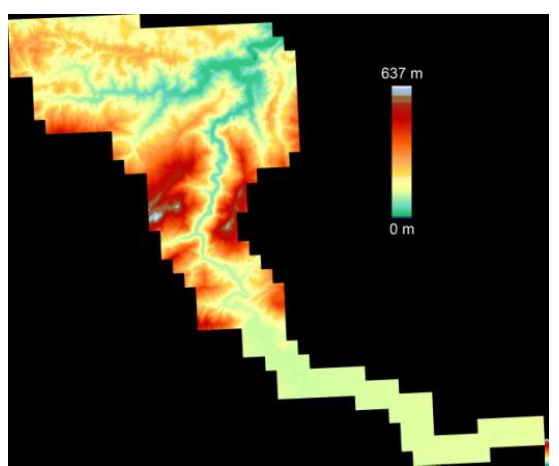
Fig. 3: Color coded reference LiDAR DSM, range: 23.7 km x 21.4 km